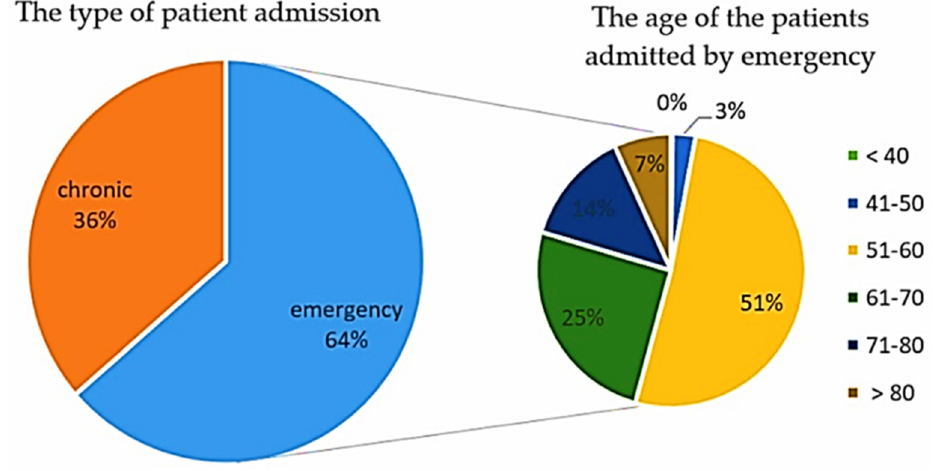
Figure 4. The distribution of heart disease in patients from N-COV BATCH. HTN—arterial hypertension, ICM—ischemic cardiomyopathy, Afib—atrial fibrillation, AFL—atrial flutter, PTE—pulmonary thromboembolism, ATS—atherosclerosis.